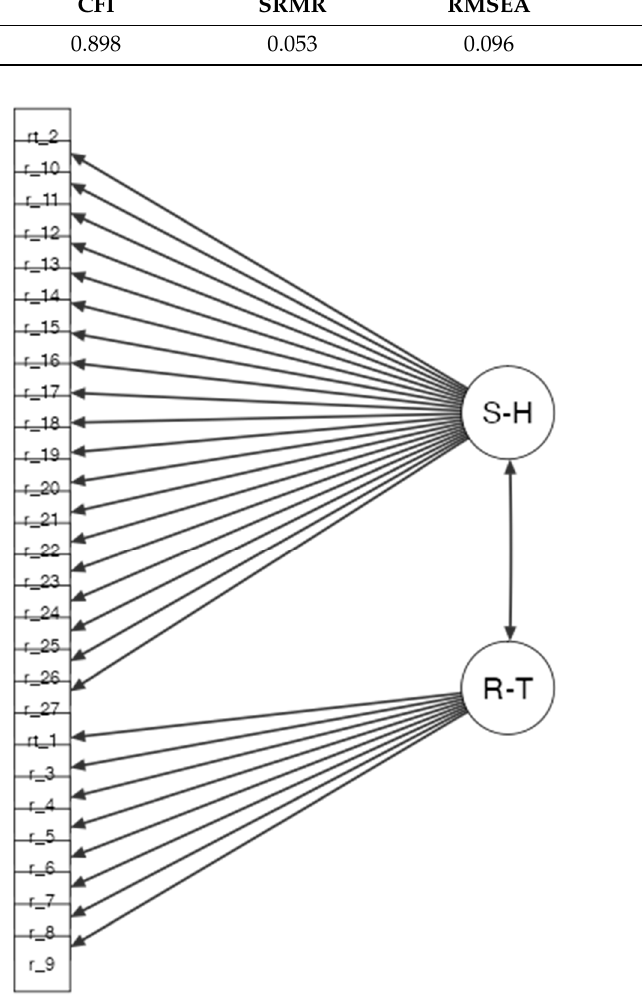
Figure 2. Graphical summary of the Confirmatory Factor Analysis obtained from the 27 items of the Risk Taking and Self Harm Inventory for Adolescents (RTSHA-I) (N = 654). Table 3. Fit Measures without Modi fi cation Indices.